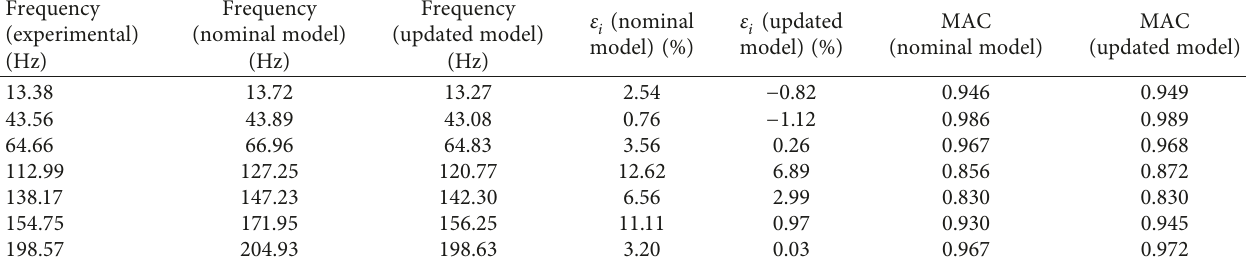
Table 4: Comparison of the experimental and analytical modal properties.